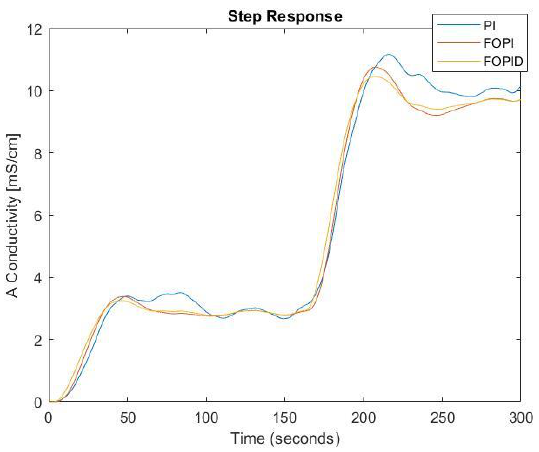
Figure 19. Step responses of the closed-loop system for the integer-order PI, FO-PI, and FO-PID controllers in the case of main flow changes.